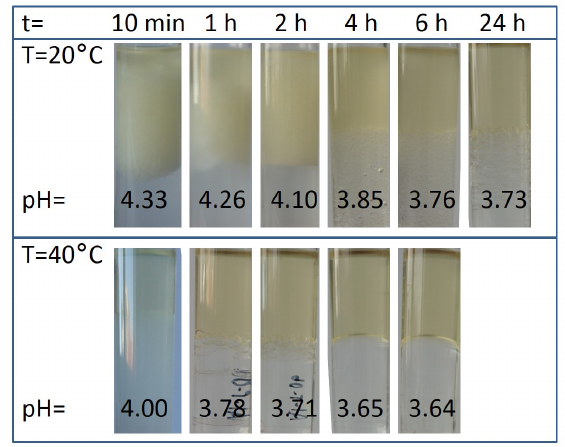
Figure 4. Effect of shaking time and extraction temperature on the equilibrium pH of the aqueous phase and phase